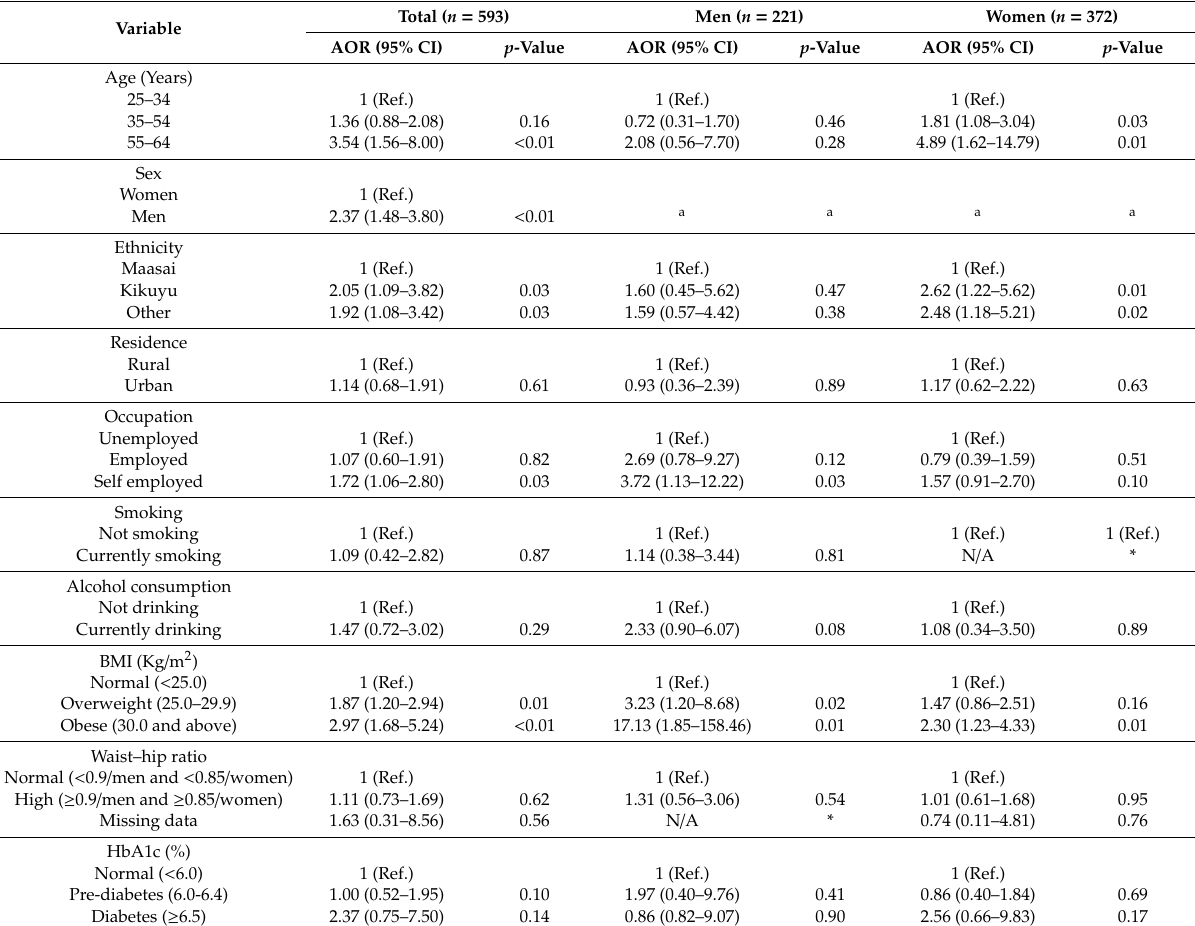
CI: Confidence Interval; AOR: Adjusted Odds Ratio (all the variables in the table were mutually adjusted for each other in the multivariable analysis). Ref: Reference group; BMI: Body Mass Index; N / A: The number with missing data was very small; thus, the confidence interval could not be computed. * The number with missing data was very small; hence the p -value could not be computed. a Data has already been segregated by sex (No values to